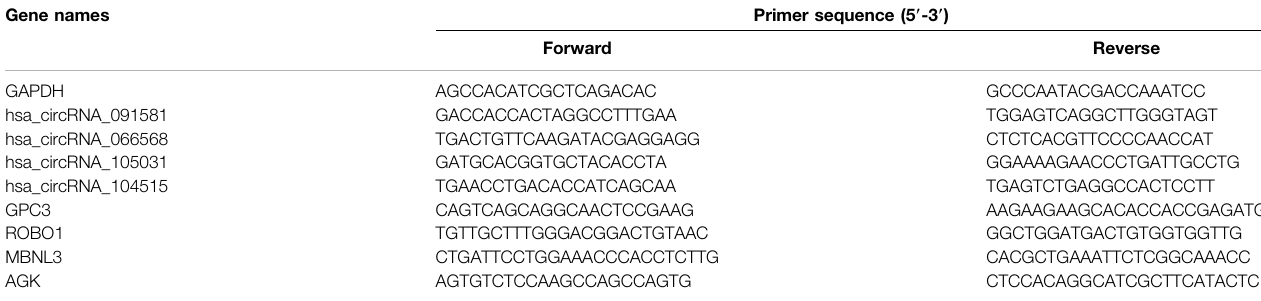
TABLE 1 | Primer sequences of RNAs for